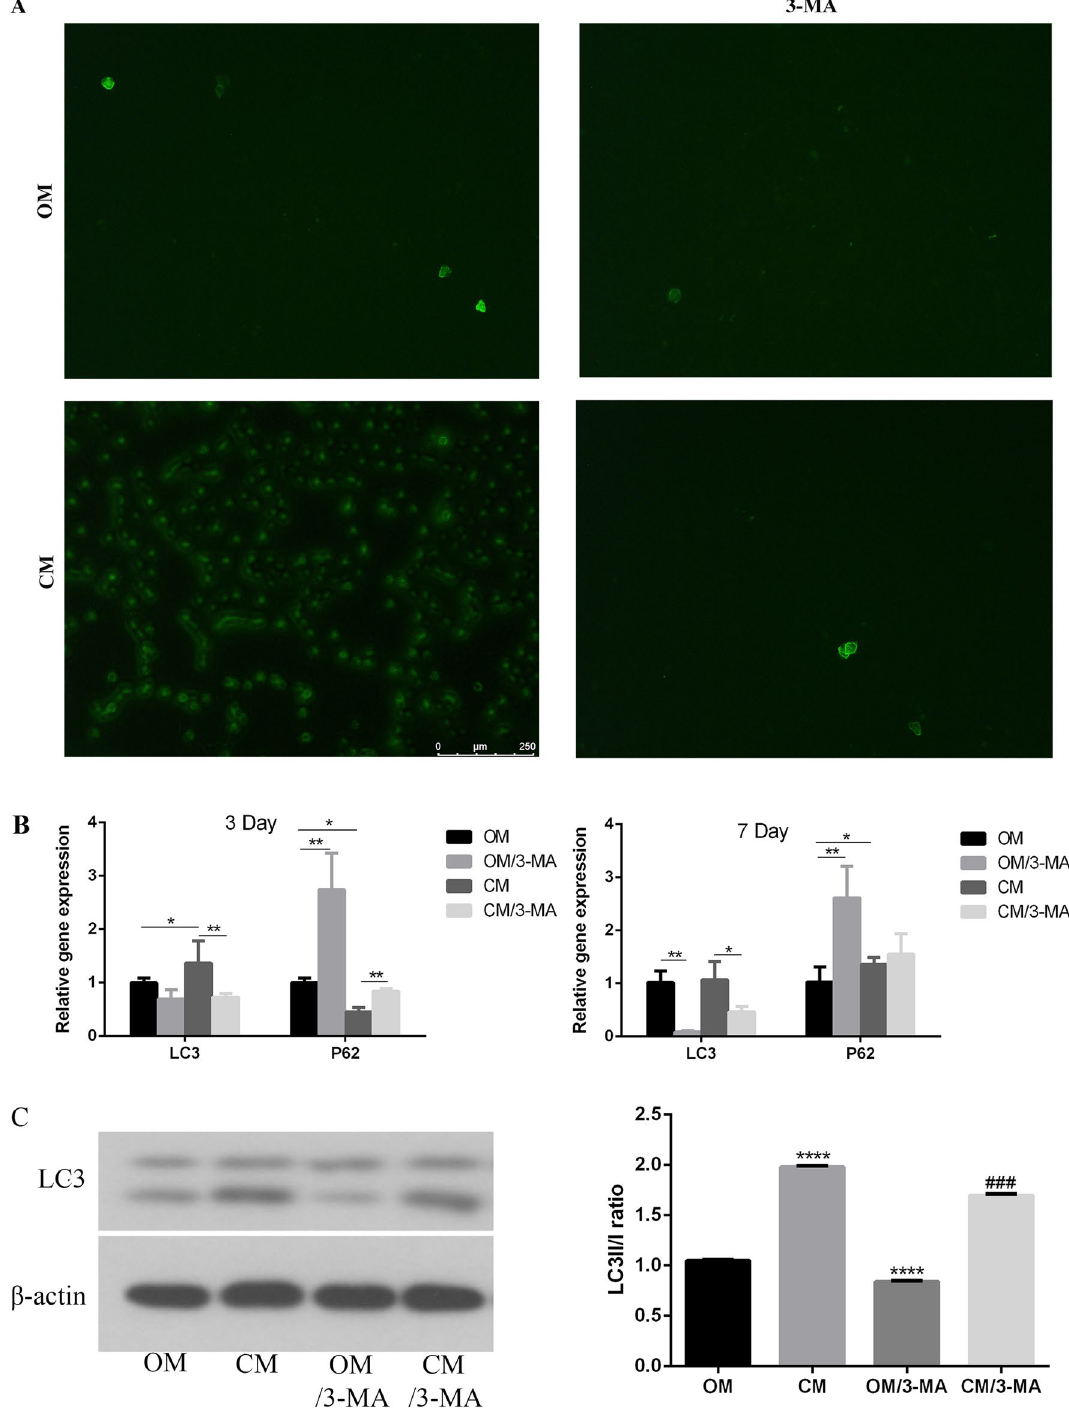
Figure 4. Detection of autophagy level of MC3T3-E1 cells under OM and CM culture conditions with or without 3-MA. ( A ) MDC autophagy body staining (Autophagosomes were shown in green); ( B ) real-time quantitative PCR showed the expression of autophagy related genes LC3 and P62 at day 3 and 7. ( C ) Western blot showed the expression of LC3II/[ OM osteogenic induction medium, OM/3-MA adding 5 mM autophagy inhibitor 3-MA to osteogenic induction medium, CM conditional medium (osteogenic induction medium and the supernatant of RAW264.7 cells’ culture medium), CM/3-MA adding 5 mM autophagy inhibitor 3-MA to the conditioned medium. * p < 0.05; ** p < 0.01; *** p < 0.001; **** p <